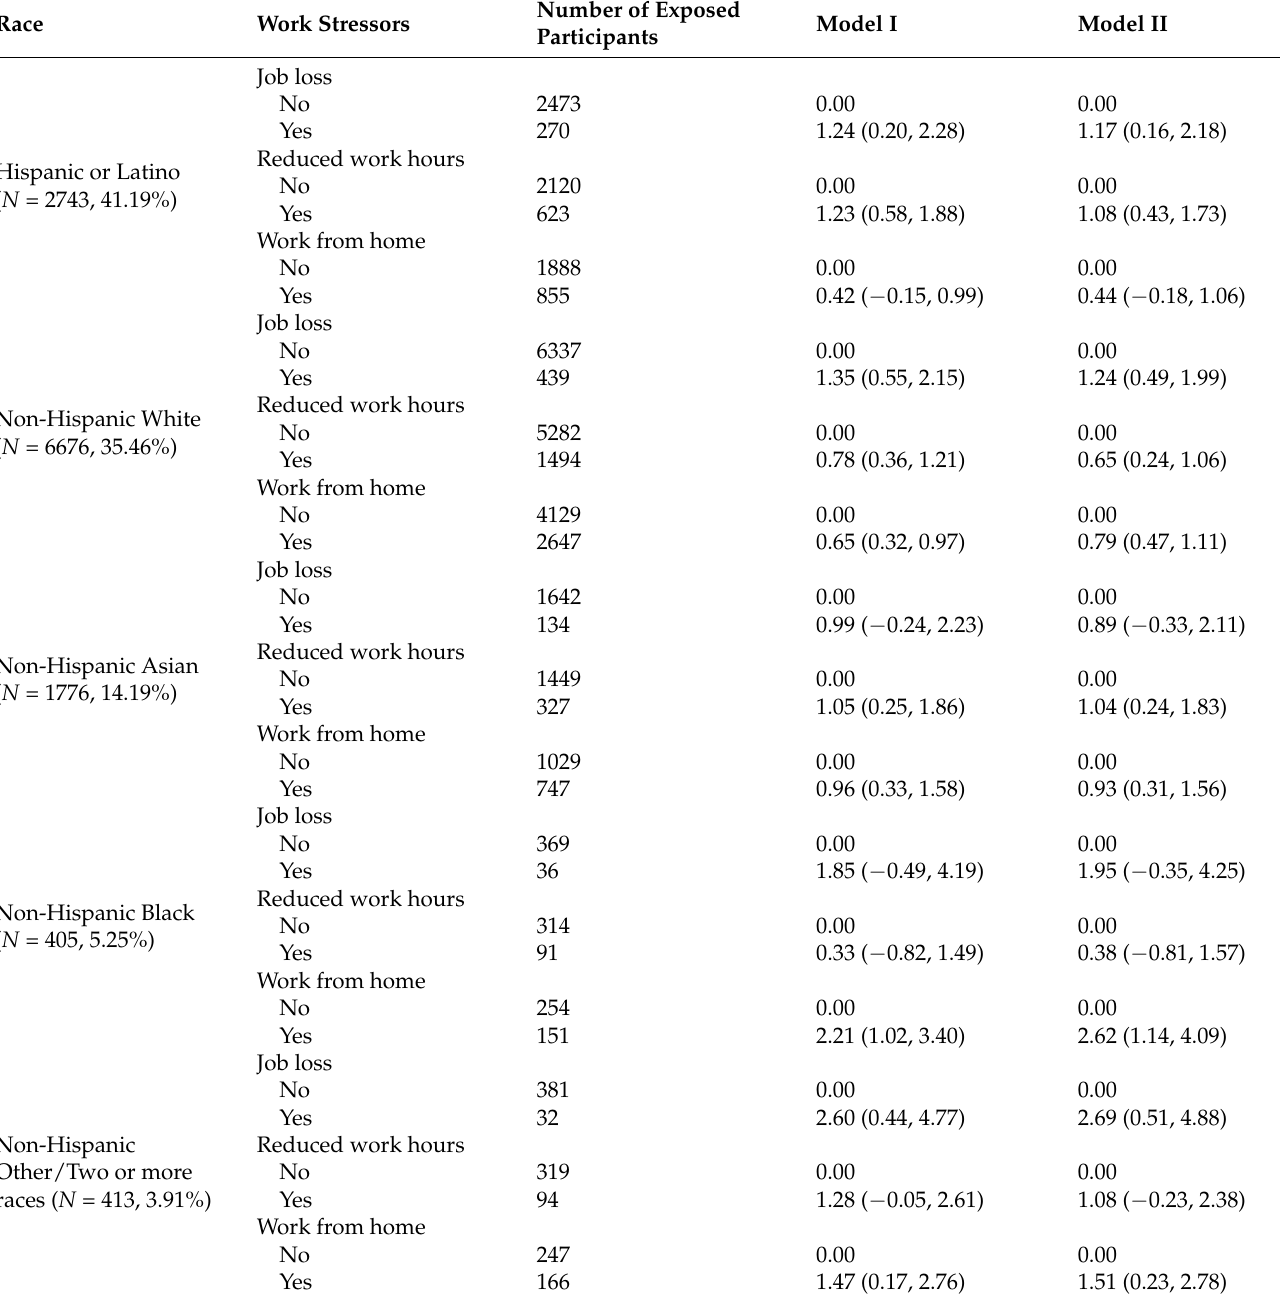
Table 3. Associations of Work Stressors with Psychological Distress by Race ( β s and 95% CIs) ( N =